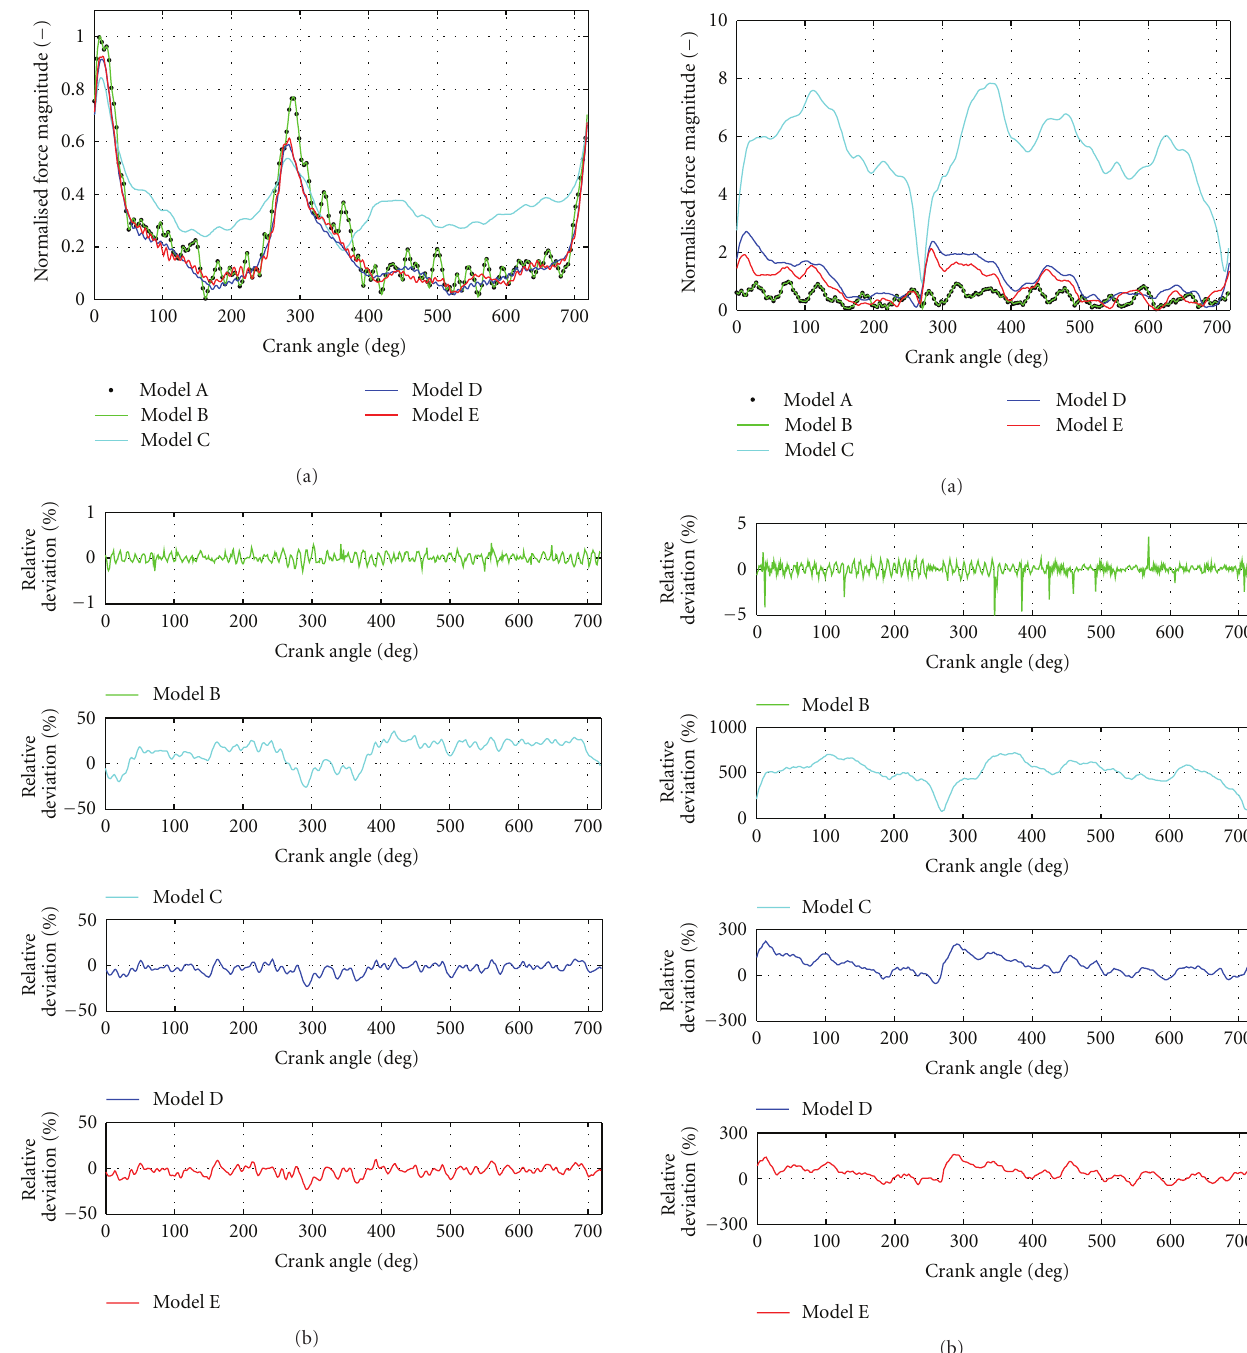
Figure 6: ( a) Central main bearing 2 normalized force magnitude; (b) relative percentage deviations of Models B, C, D, and E, respectively.